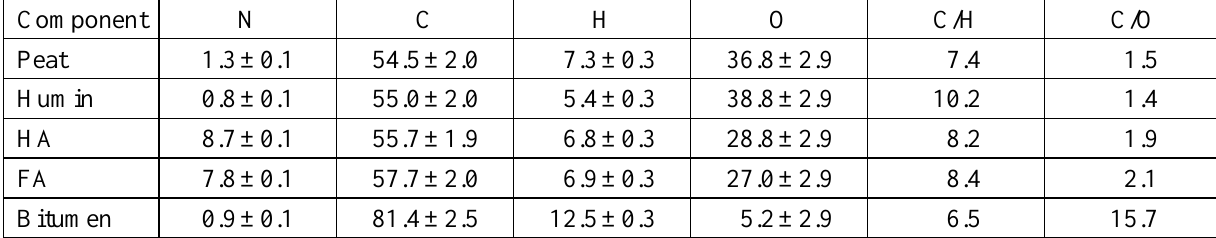
Table 5. Average concentrations (% ± SD) of the main elements in Arkhangelsk peat and its components. Component